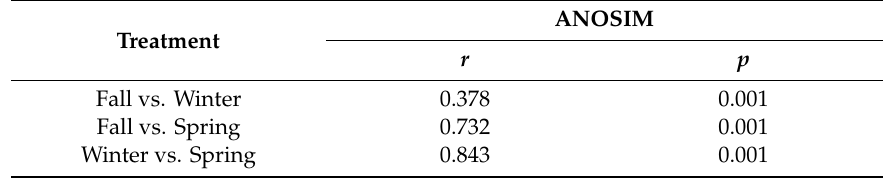
Table 1. Di ff erences in the bacterial community composition based on the similarity test of ANOSIM.